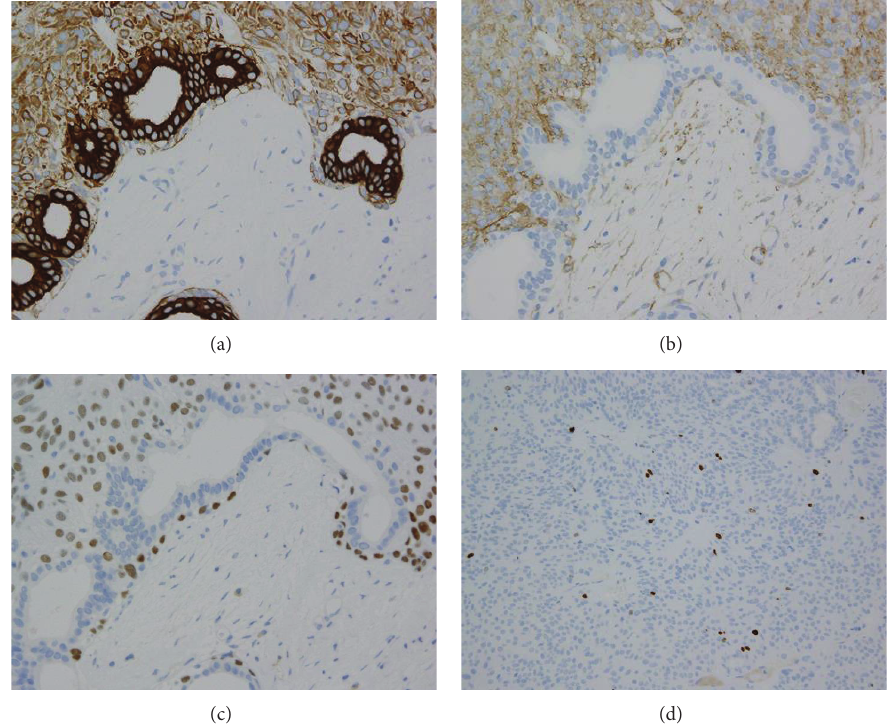
Figure 5: Results from immunohistochemistry. (a) CK7 ( × 100): lumen cells of glands showed strong staining and outer cells showed weak staining. (b) 𝛼 -SMA ( × 200): outer cells showed cytoplasmic staining. (c) p63 ( × 200): outer cells showed nuclear staining. (d) MIB-1 (Ki-67) ( × 100): the MIB-1 (Ki-67) labeling index was extremely